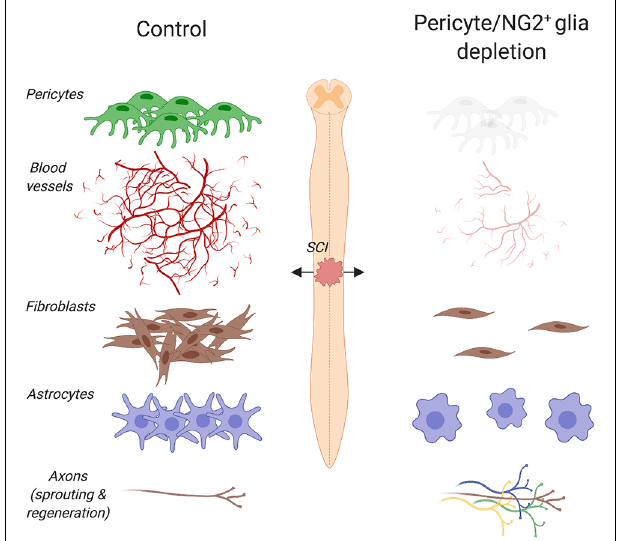
FIGURE 2 | Pericyte/NG2 + glia depletion and its effects on the pathophysiology of spinal cord injury (SCI). Ablation of pericytes and NG2 + glia impairs angiogenesis, dampens astrogliosis and completely abolishes fibrotic scar formation at the lesion site. Under such pathophysiological conditions, a greater axon regrowth into the lesion is observed. Created with